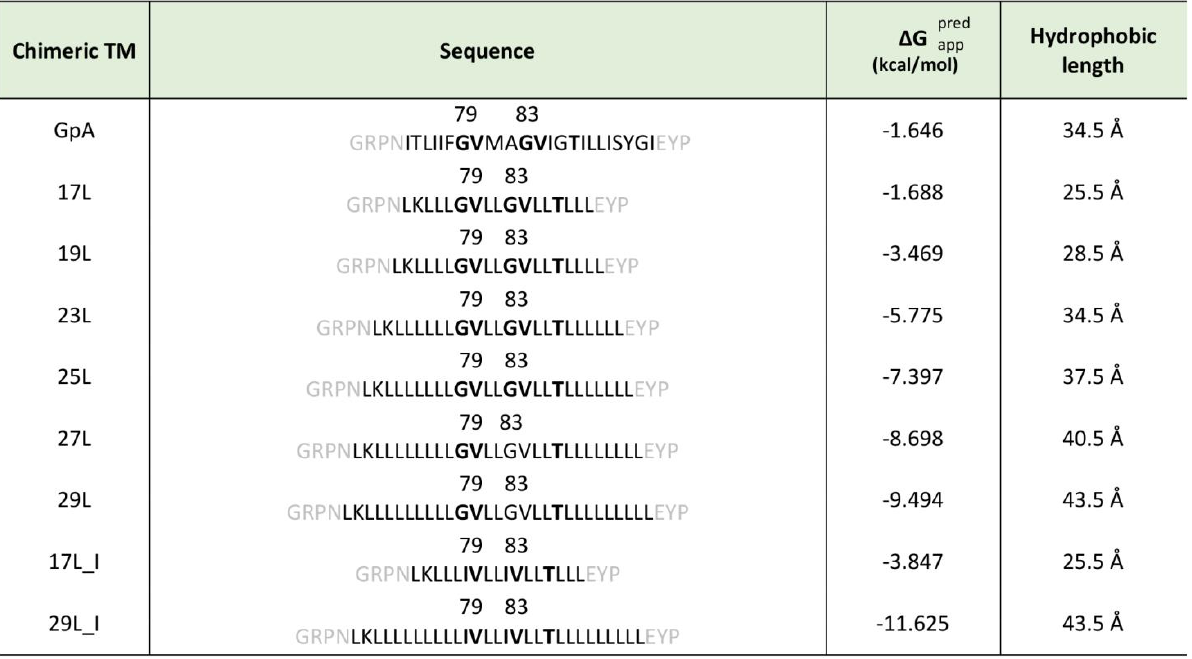
Table 1. Sequences predicted ΔG and hydrophobic length of transmembrane